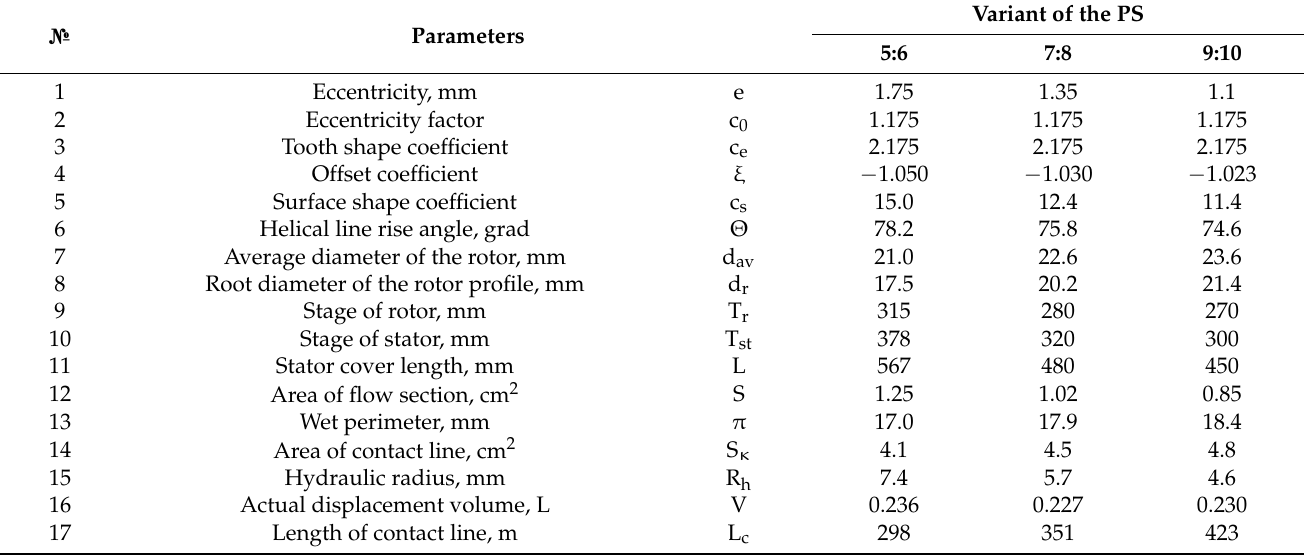
Table 3. Geometric and operational parameters of the power section of the PDM with the diametrical dimension of the sleeve being 43 mm (D c = 28 mm; V = 0.235 L; M = 75 N · m; P = 4 MPa; Q = 1 L/s; η hm = 0.5; η v = 0.8; k =